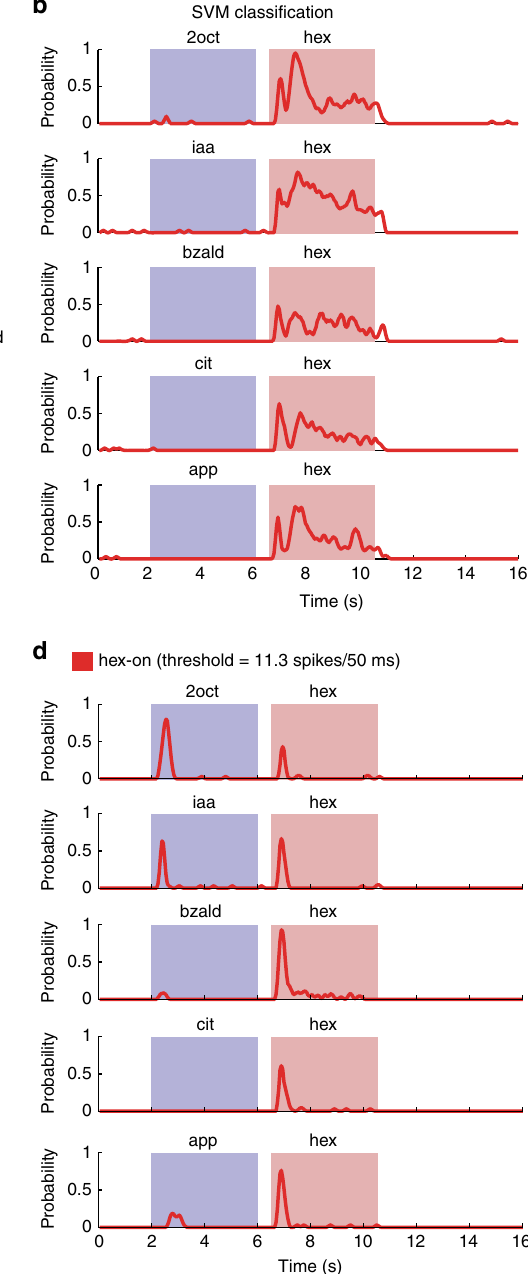
Fig. 6 Linear neural decoding of ensemble neural activities. a A schematic of the multi-class linear support vector machine (SVM) classi fi er is shown. Here again the input to the classi fi er was an 85-dimensional ensemble PN activity vector in a 50 ms time bin ( x ( t )). The optimal weight vector that separates hexanol responses for all other odor-evoked and baseline activities was determined and is shown as a color bar ( v svm ). Contribution of each PN was weighted based on the corresponding weight vector component ( v svm T x ( t )) and thresholded to produce a binary classi fi cation output: ‘ hexanol present ’ or ‘ hexanol absent ’ . Note that the number of parameters here are 86 (number of neurons and threshold). Probability of classi fi cation in each time bin was determined by averaging classi fi cation results across trials. b The probabilities of hex classi fi cation using the linear SVM classi fi er, across trials are plotted as a function of time for different hexanol presentations. c A schematic of the fl exible set decoder is shown. Ensemble PN activity vector in a 50 ms time bin ( x ( t )) was the input to the classi fi er. The weight vector v had the same number of components as x ( t ). A vector component of ‘ 1 ’ was assigned corresponding to PNs that were responsive to the solitary hexanol introductions, and ‘ 0 ’ was assigned corresponding to non-responsive PNs. A dot product of x ( t ) and v resulted in summation of all hexanol responsive PNs. This scalar value was subsequently thresholded to determine the classi fi er output. The threshold to be exceeded was set to allow fl exible subsets of neurons to contribute towards reaching the cutoff value. A digital version of the classi fi er when input vector x ( t ) was also binarized and is shown in Supplementary Fig. 7. d Classi fi cation probabilities for the fl exible set decoder are shown. Same convention as in b . The value of the only free model parameter, i.e., the classi fi cation threshold, is also